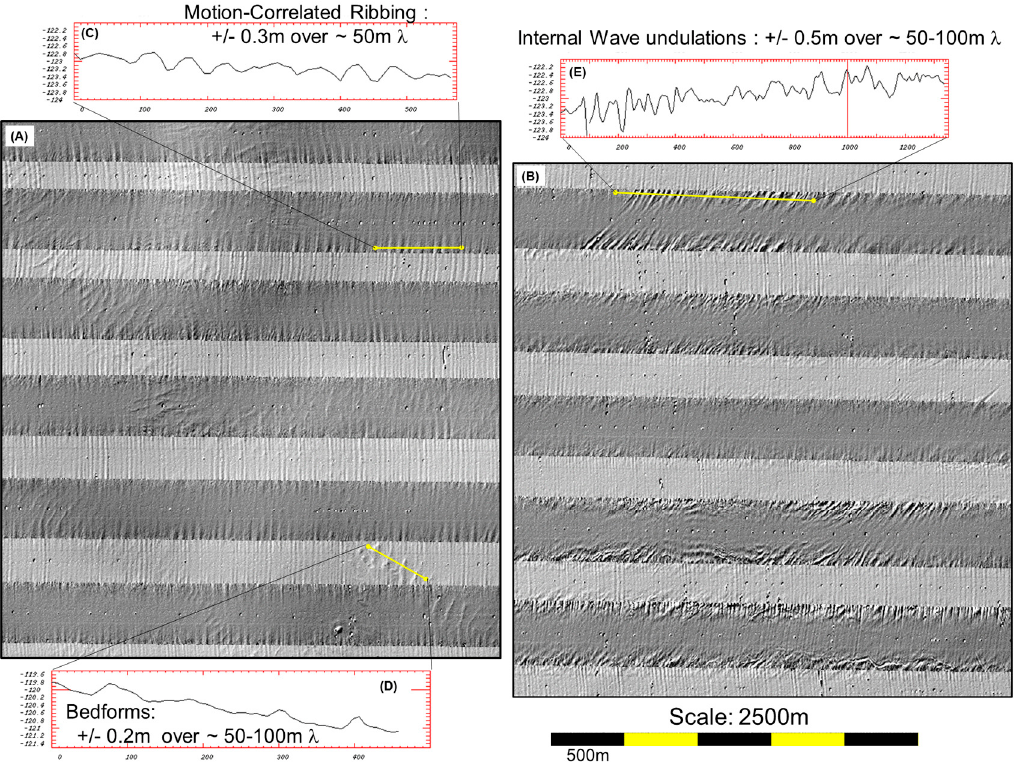
Figure 15. ( A , B ) Showing two different examples of sound speed related artifacts overprinted on a very smooth seafloor in ~120 m of water. The data were collected using a ±61° sector with just 20% overlap. The data are deliberately presented as a sun-illuminated terrain with eastbound lines stenciled separately on top of the west bound coverage. In that manner, the mismatch in the outer swath roughness of the eastbound lines (presented in a darker greyscale) can be compared with corresponding adjacent relief on the westbound lines (a lighter greyscale). Section ( C ) shows the relief due to motion-correlated errors due to near surface sound speed effects. Section ( D ) shows the strongest true geomorphic relief (faint sand ridges). Section ( E ) shows the false topography generated by the passage of an internal wave packet. Further sinuous morphology, indicative of internal wave activity, can be seen on the outer edges of the southernmost two lines.